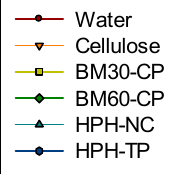
9 of 19 Figure 2. SEM images of ( a , b ) untreated cellulose, cellulose treated by ball milling for ( c , d ) 30 min and ( e , f ) 60 min, by ( g , h ) HPH treatment for 10 min, and ( i , j ) HPH-treated tomato pomace aqueous suspensions. 3.1.2. Interfacial Tension The effect of the suspended particles, processed with different mechanical treatments, on the interfacial tension at the O/W interface, is a predictor for emulsion formation and stability, as well as its mean droplet size [26]. In general, the higher the interfacial tension, the more resistant the whole system is to deformation and the more likely phase separation between the two liquids occurs. The results reported in Figure 3, as kinetic data of interfacial tension, clearly show that the oil phase still contains significant impurities, also after filtering the oil with a PTFE filter. Therefore, the interfacial behavior of the samples is dominated by the behavior of the control sample. In general, the systems where cellulose was added did not show any noteworthy reduction in interfacial tension compared to the control, with the exception of the HPH-NC sample, which exhibited an interfacial tension that was consistently lower than the other samples. More specifically, the BM30-CP and BM60-CP samples did not show an enhanced surface activity compared to the untreated cellulose, with the dynamic interfacial tension curves for cellulose and BM30-CP that are almost identical and the